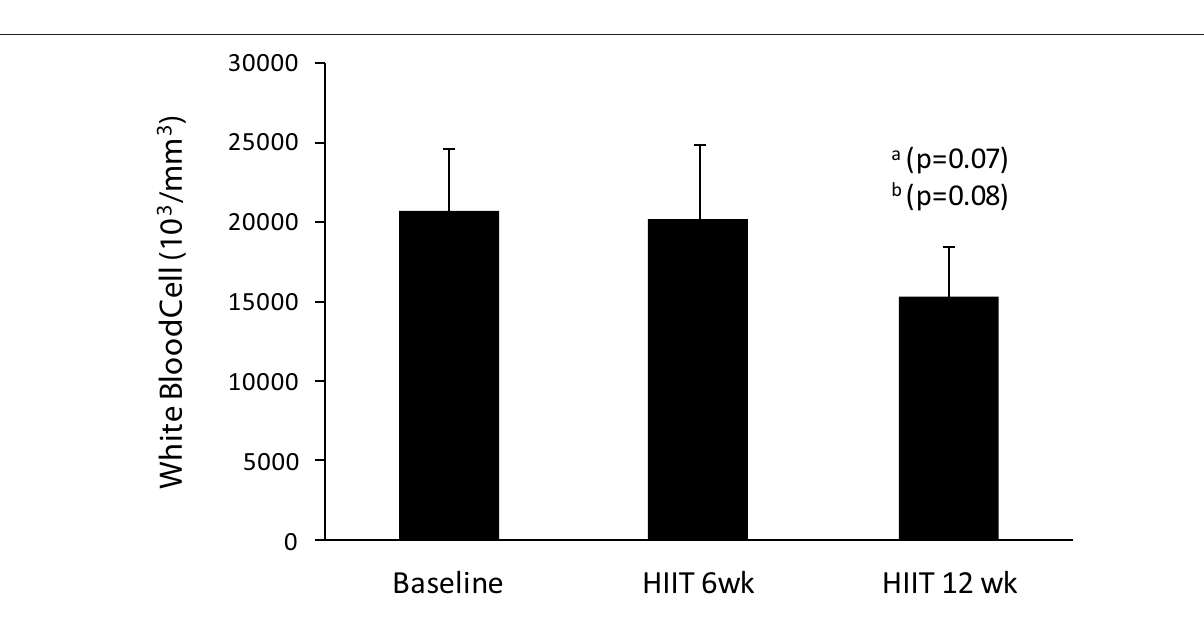
FIGURE 5 | Values of white blood cells in baseline, HIIT short term, and HIIT long term. a Trend to difference ( P ≤ 0.07) in relation to baseline. b Trend to difference ( P ≤ 0.08) in relation to 6 HIIT short